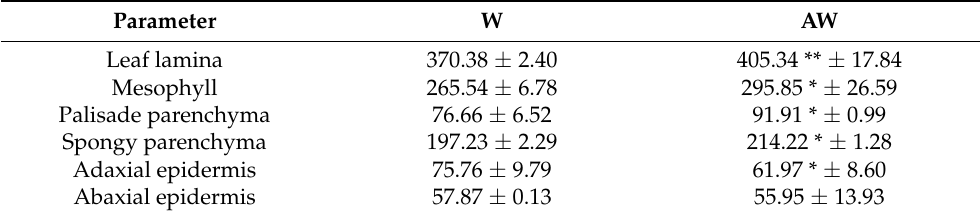
Table 4. Thickness ( µ m) of leaf lamina and its tissues and palisade factor (%) in L. discolor plants grown in W-irrigated and AW Week 4 -fertilized soil. Parameter W AW Leaf lamina 370.38 ± 2.40 405.34 ** ± 17.84 Mesophyll 265.54 ± 6.78 295.85 * ± 26.59 Palisade parenchyma 76.66 ± 6.52 91.91 * ± 0.99 Spongy parenchyma 197.23 ± 2.29 Adaxial epidermis Abaxial epidermis 57.87 ± 0.13 55.95 ±